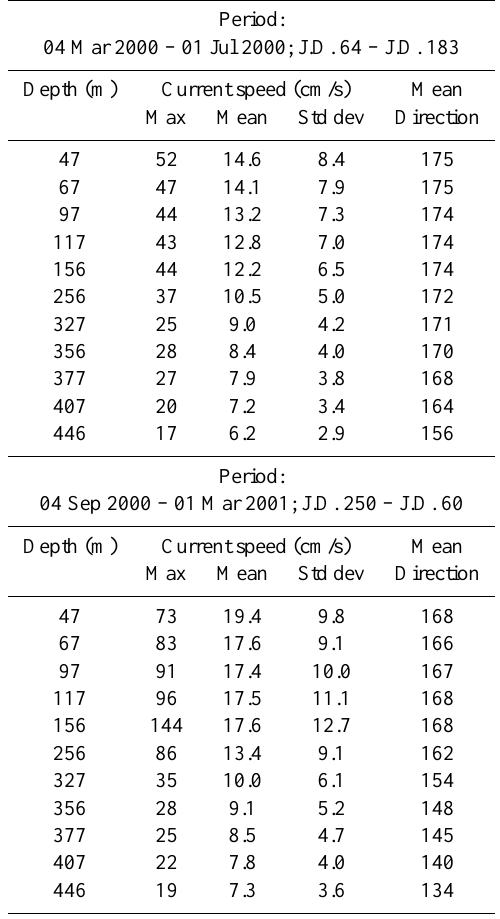
Table 2. Statistical parameters of ADCP